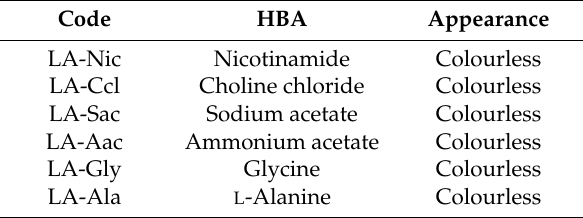
Table 2. Codes of the DES synthesised and the corresponding HBAs used. All DES were tested at R D / A of mol